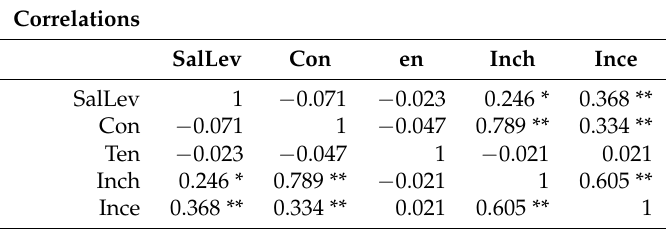
Table 7. Pearson correlations between the independent variables of the linear regression model described in Equation (6) for data collected in January 2013. ** The correlation is significant at the 0.01 level (two-tailed). * The correlation is significant at the 0.05 level